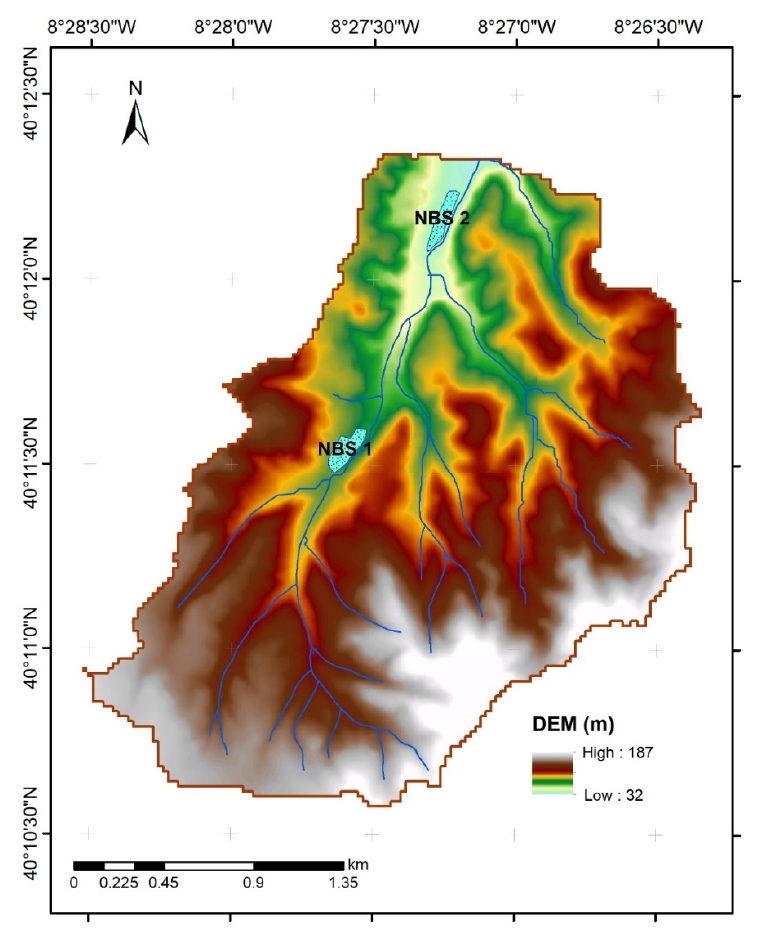
Figure 3. Location of two nature-based solutions (NBS) in the Ribeira dos Cov õ es catchment investigated in this study, based on local